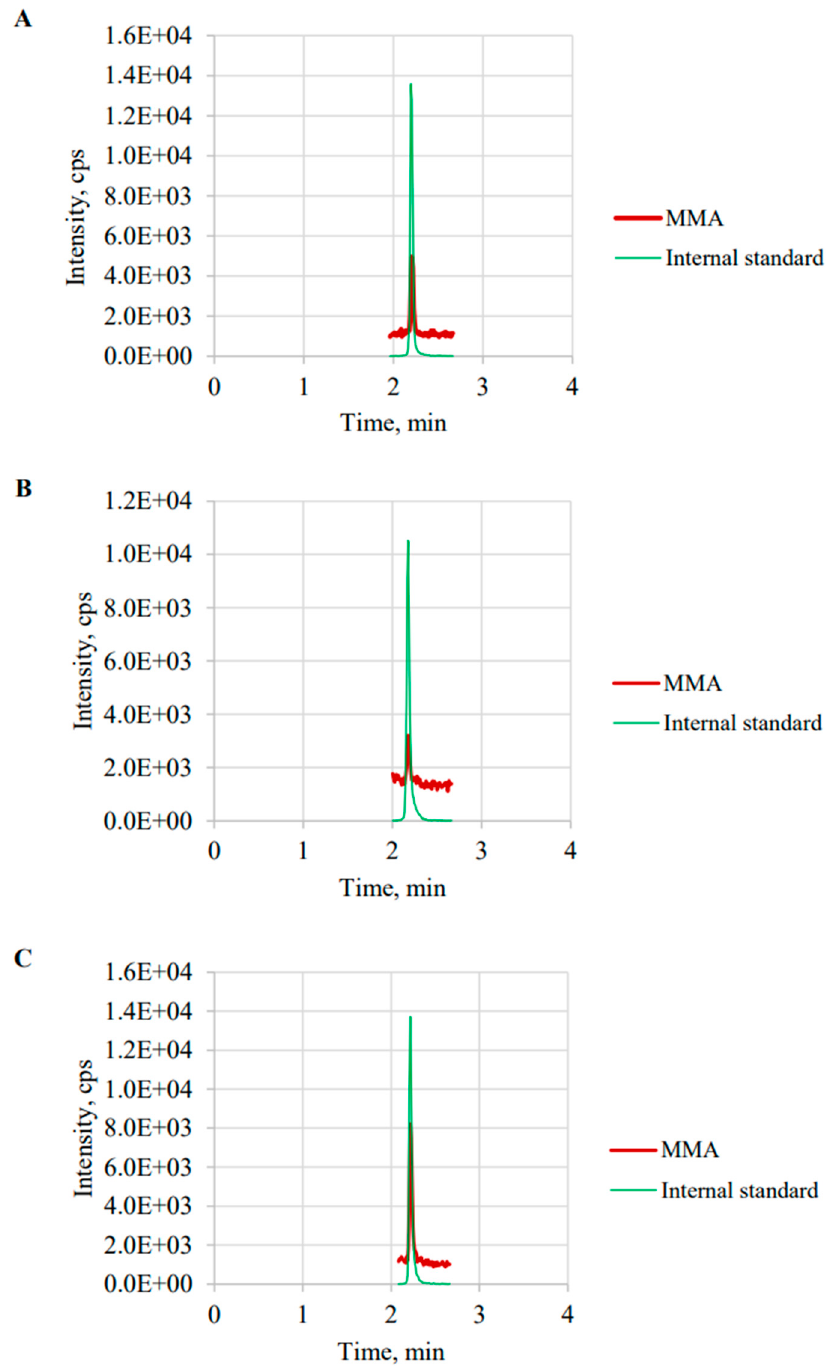
Figure 2. Representative chromatographs of: ( A ) calibrators; ( B ) healthy controls; ( C ) patients.